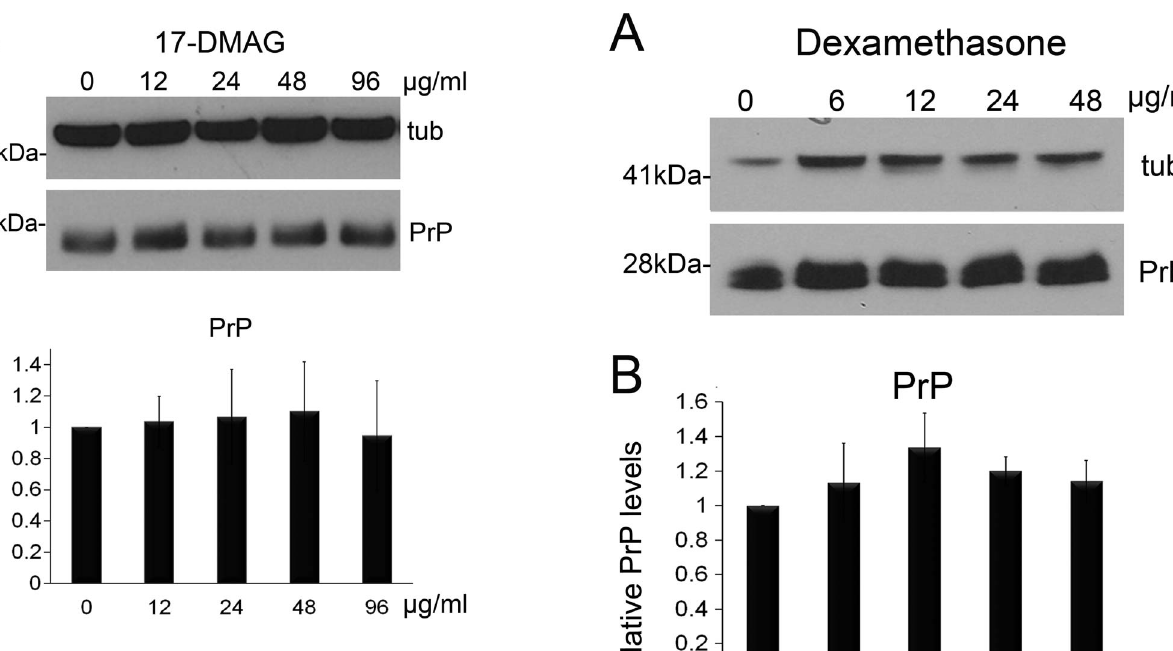
Figure 1. 17-DMAG has no effect on PrP expression. A , Flies expressing PrP ubiquitously (da . PrP-M9) were fed with 17-DMAG at 0, 12, 24, 48, and 96 m g/ml during development. Analysis of PrP levels in 1 day-old flies by western blot showed no significant changes. Tubulin was used as loading control to normalize protein levels. B , Quantifi- cation of the triplicate experiment followed by analysis with ANOVA. No statistical differences were identified in these experiments.